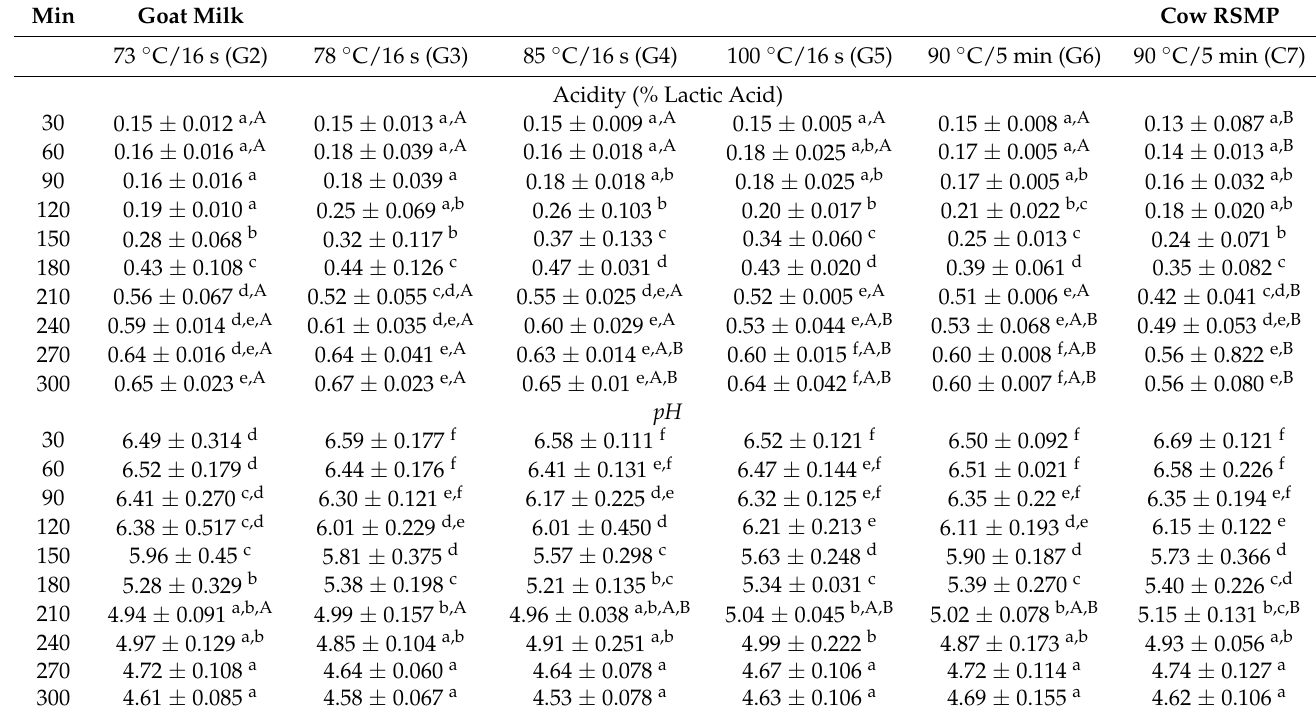
Table 4. Acidification of heat-treated homogenized goat milk, after inoculation with yoghurt starter and incubation at 43 ◦ C; means ± standard deviation. Reconstituted cow skim milk powder (RSMP) treated at 90 ◦ C for 5 min was used as control.